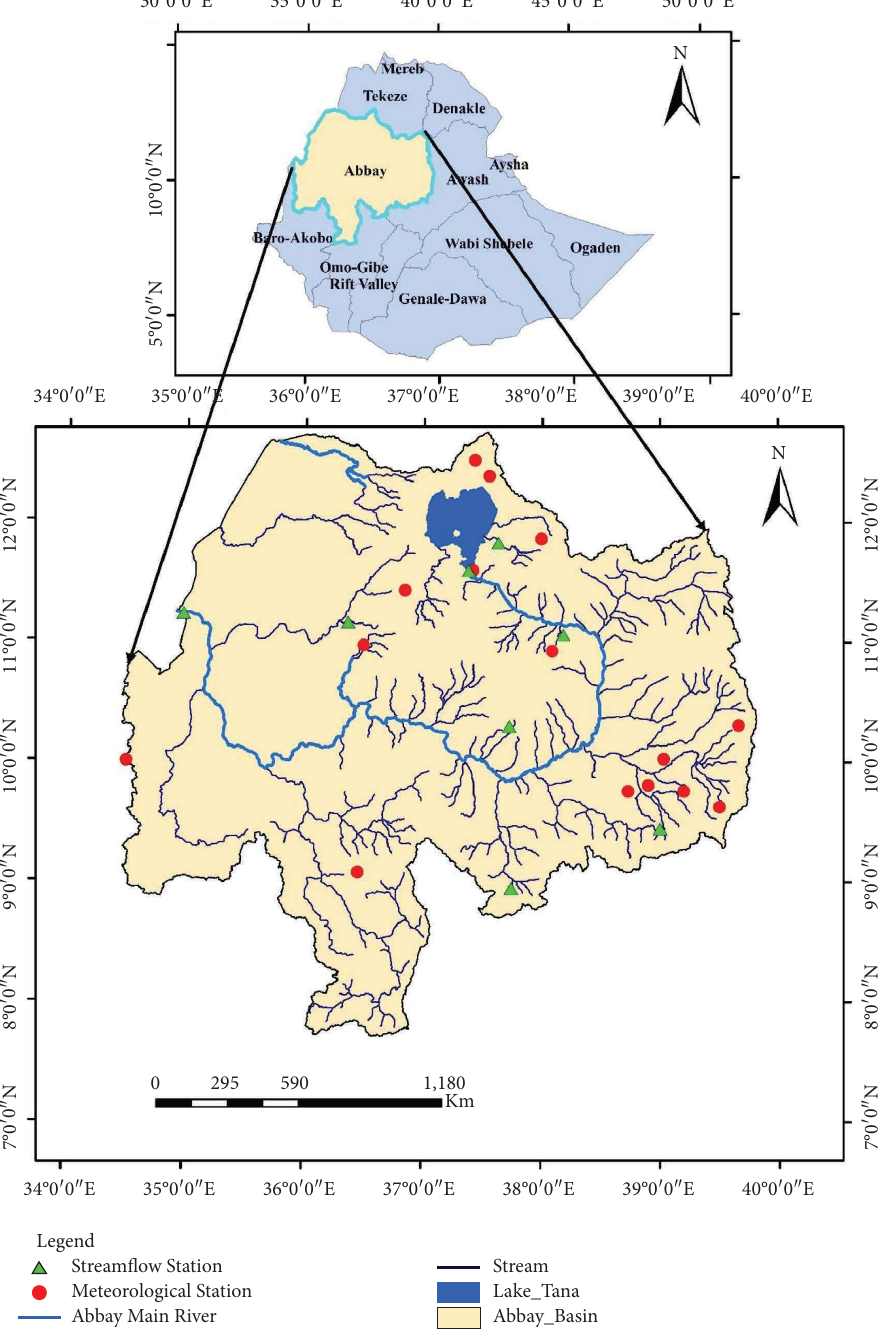
Figure 1: Location of hydrometeorological stations in Abbay river